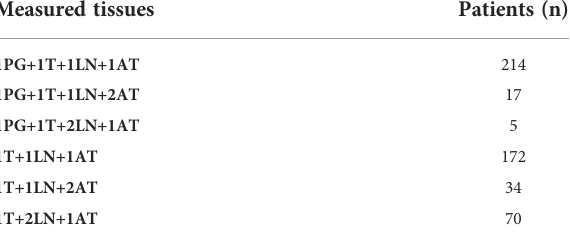
TABLE 1 The relationship between patients and measured tissues. Measured tissues Patients